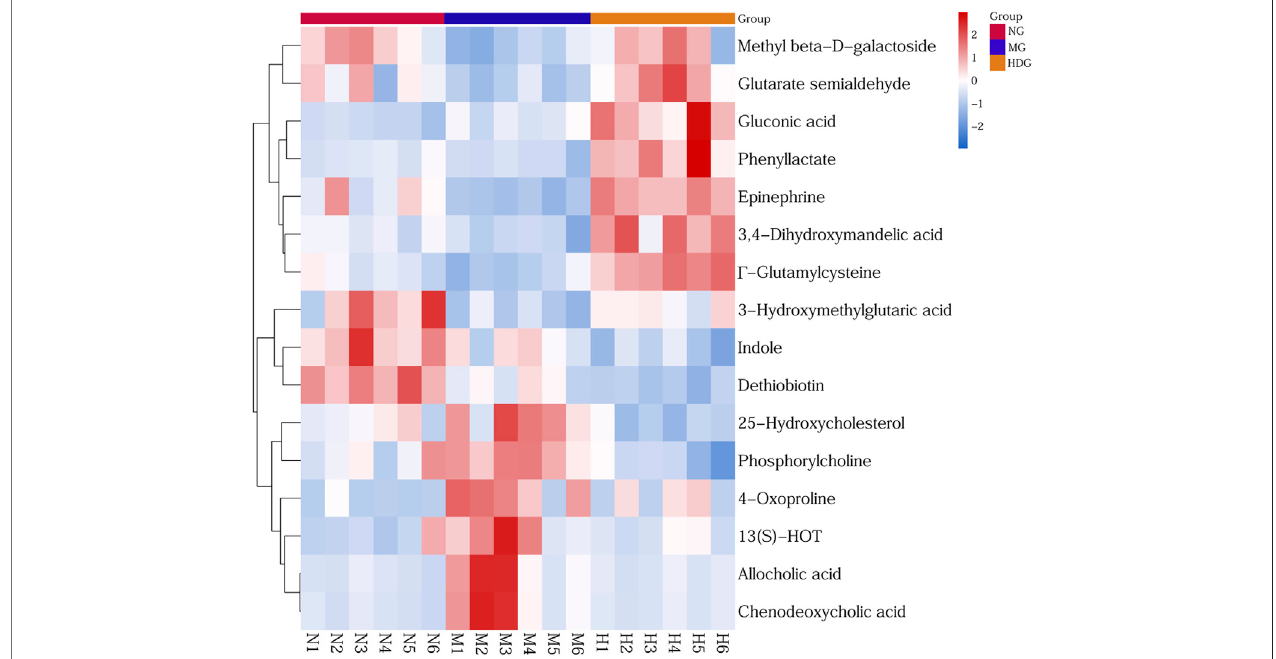
FIGURE 7 | Heatmap of differential metabolites. Color changed from blue to red, corresponding to a progressive increase in concentration.